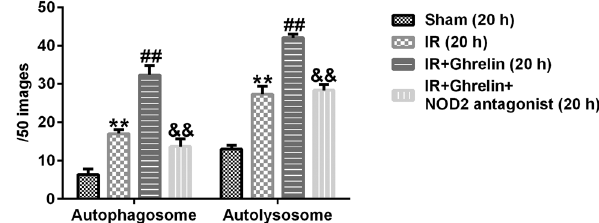
Figure 3: The number of autophagosomes and autolysosomes in the intestinal epithelium of rats. The number of autophagosomes and autolysosomes in the IR group, the ghrelin - treated group, the ghrelin and NOD2 antagonist treatment group, and the sham group at 20 h after I/R. Data were expressed as mean ± SD, n = 6;